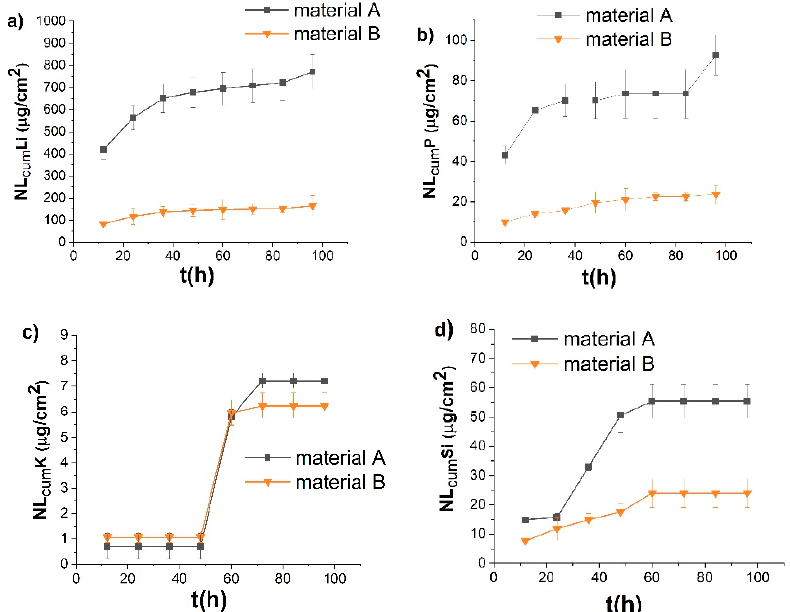
Figure 7. Time dependence of the normalized leaching of ions released from the materials studied in NaOH solution during the quasi-dynamic analysis, expressed in cumulative NL values of ( a ) Li, ( b ) P, ( c ) K and ( d ) Si.